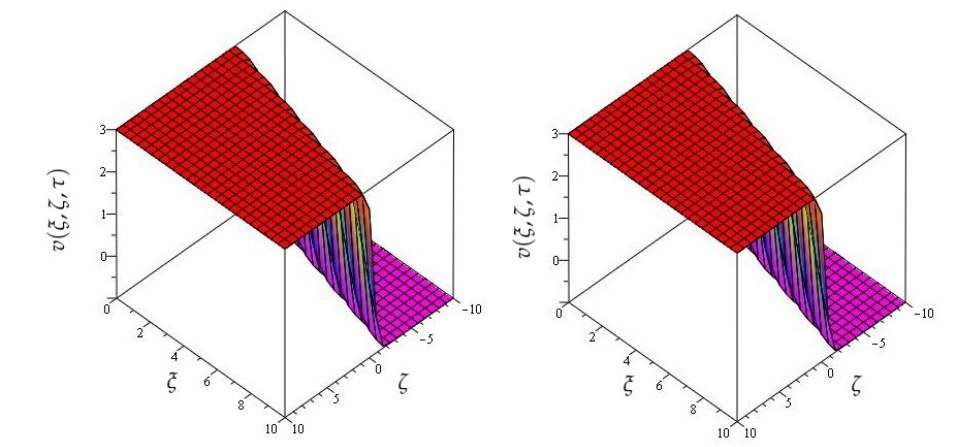
Figure 10. The exact and numerical solutions of v ( ξ , ζ , τ ) of Example 2 at β = 1.